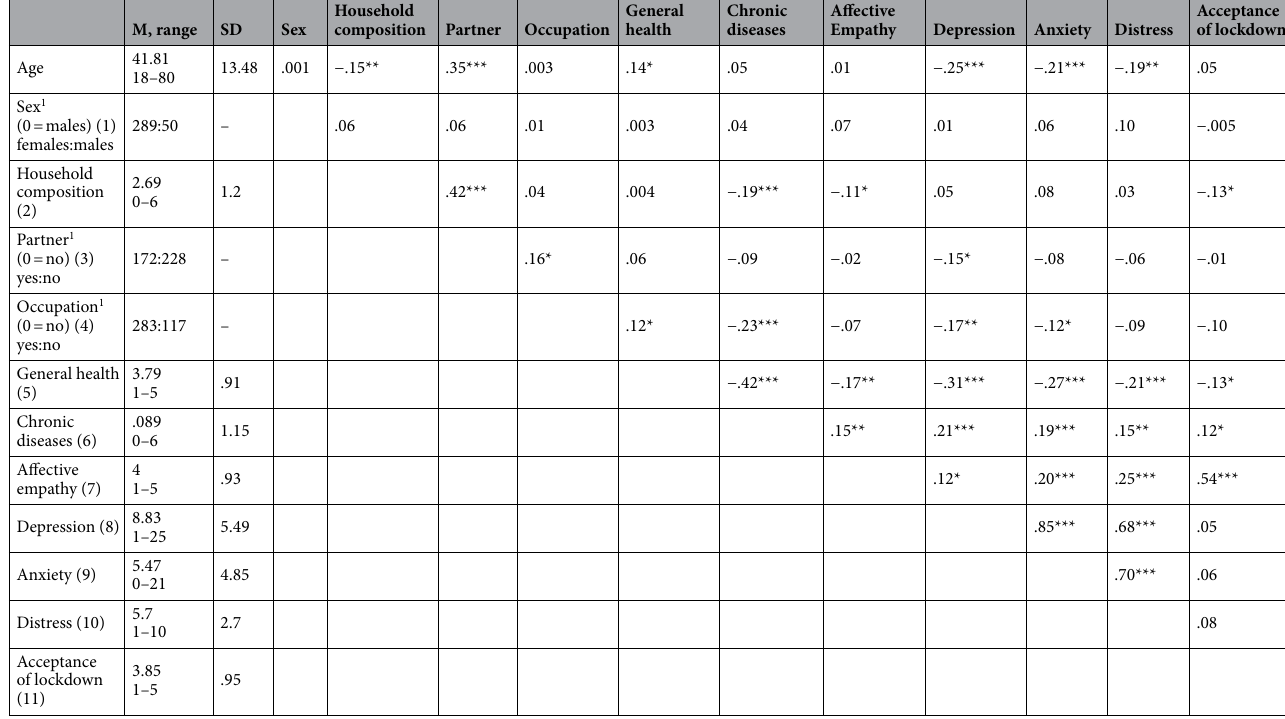
Table 2. Correlations, Phase 1. * p < .05. ** p < .01, *** p < .001; 1 = point biserial correlations were